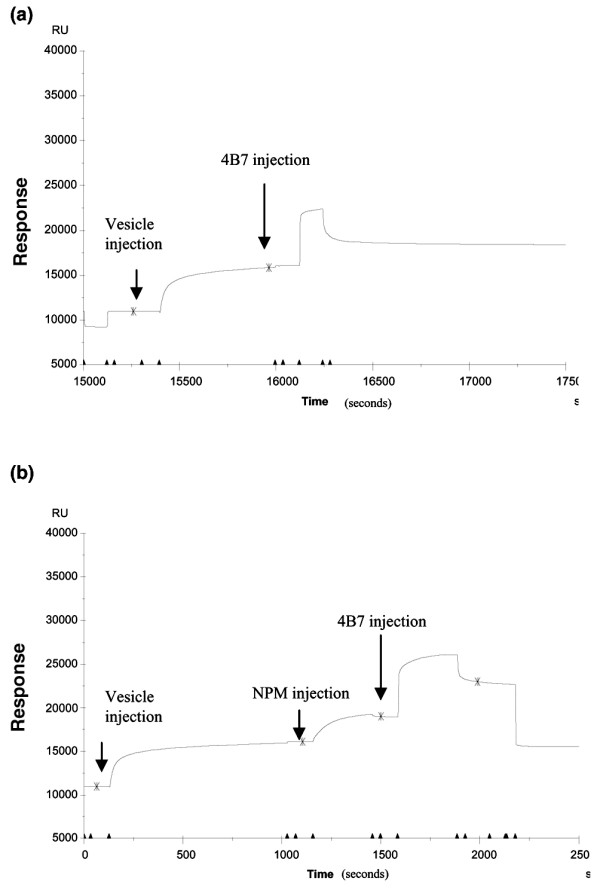
Biacore analysis of binding of 4B7 mAb to cardiolipin-nucleophosmin complexes. Cardiolipin vesicles were captured on the surface of sensor chip L1. Binding of purified 4B7 mAb to cardiolipin vesicles alone (a) or after the injection of recombinant human nucleophosmin (b).